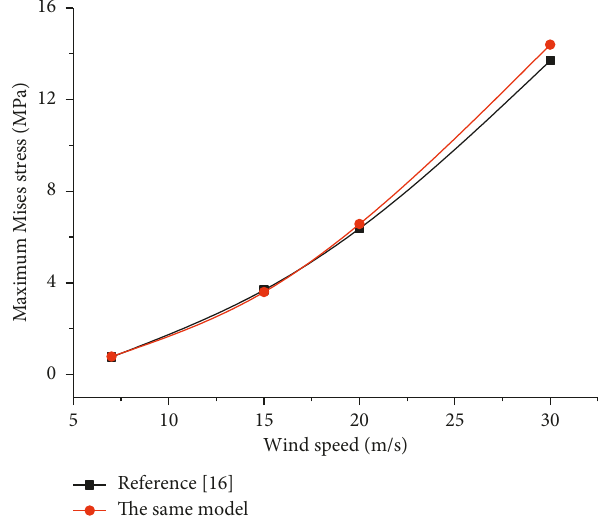
Figure 5: The maximum Mises stress